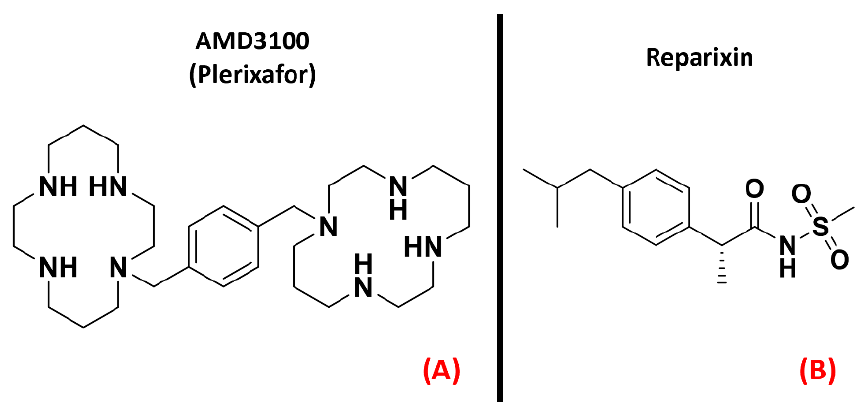
Figure 6. The chemical structures of the CXCR4 antagonist AMD3100 (also known as “Plerixafor”, ( A ) and the inhibitor of CXCR1 and CXCR2 known as Reparixin ( B ).